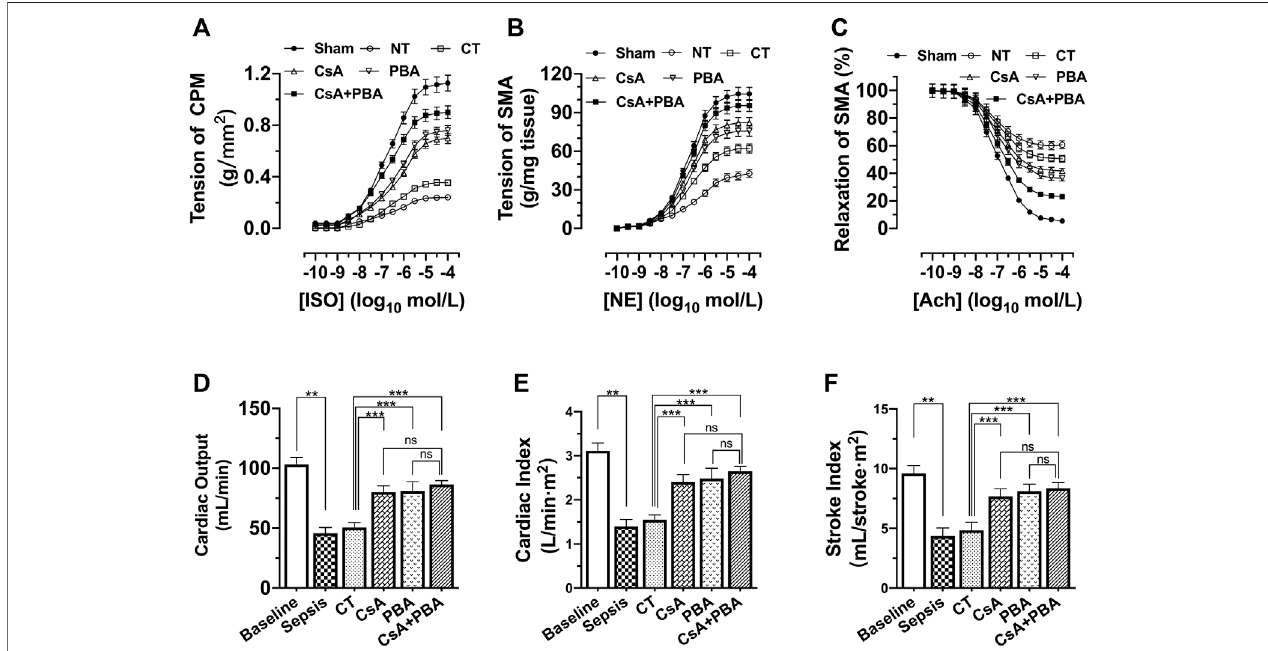
FIGURE3| SynergeticeffectofPBAandCsAonimprovingcardiovascularfunctionaftersepticshockinrats.( n (cid:1) 8/group). (A) ,thecontractileresponseofcardiac papillary muscle (CPM) to ISO; (B) , contractile response superior mesenteric artery to NE; (C) , relaxation response of superior mesenteric artery to Ach; (D) , cardiac output (CO); (E) , cardiac index (CI); (F) , stroke index (SI). CsA, cyclosporine A; PBA, 4-phenylbutyrate acid; CT, conventional treatment; ISO, isoprenaline; NE, norepinephrine; Ach, acetylcholine. * p < 0.05, ** p < 0.01, *** p < 0.001; ns , not signi fi